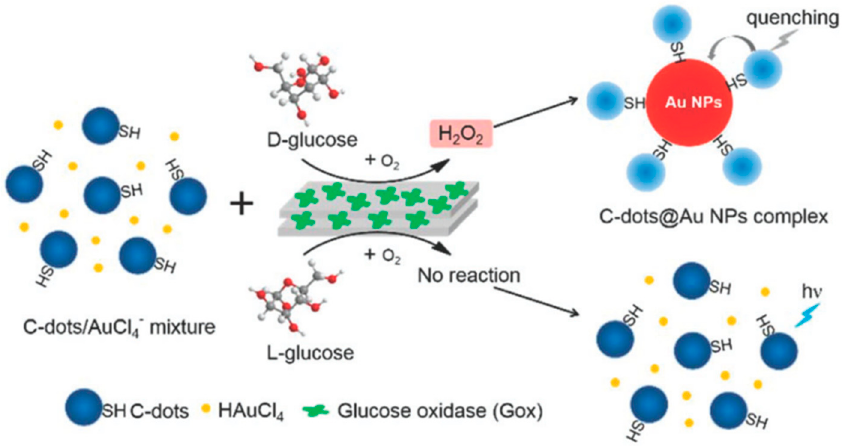
Figure 4. Schematic representation for the generation of C-dots@AuNP complex trigged by the stereoselective enzymatic reaction for the discrimination of glucose enantiomers. The figure and the caption have been adapted with permission from [57], Copyright © 2018 The Royal Society of Chemistry.